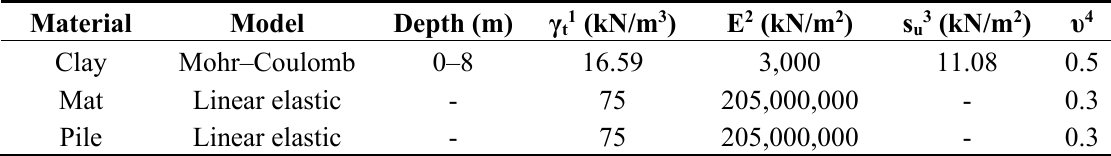
Table 1. Material properties for small-scale model load test.